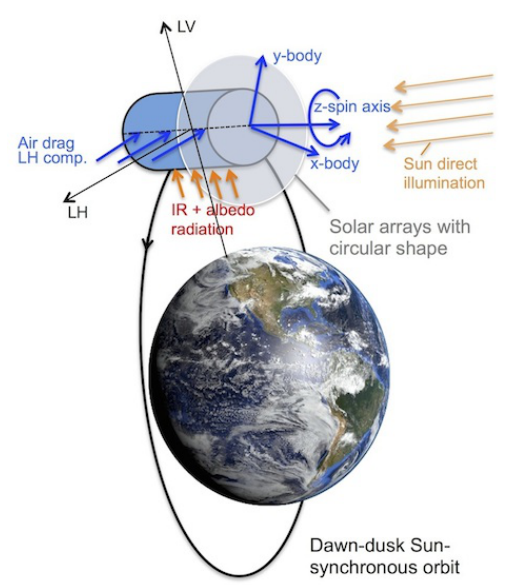
Figure 1. Schematic of the proposed METRIC spacecraft and orbit. This configuration enables a separation among different dynamical